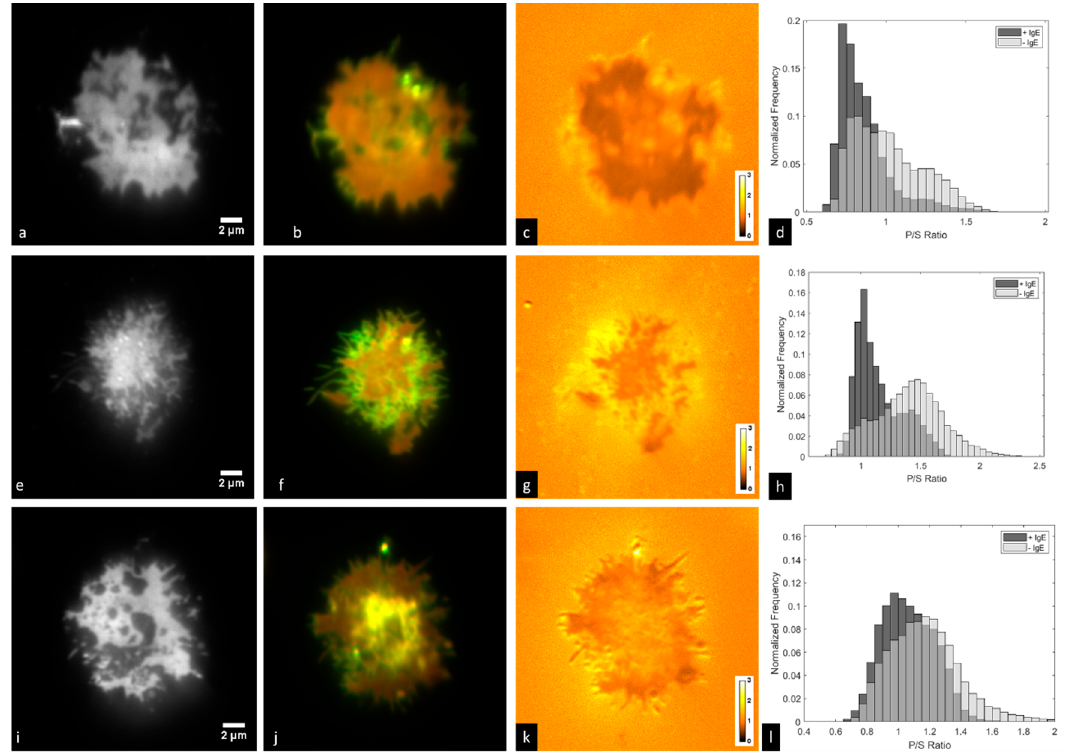
Figure 5. RBL-2H3 cells labeled with IgE-488 and DiI-C 16 in contact with a supported lipid bilayer containing 25% DNP-CAP-PE. Shown are ( a , e , i ) IgE-488; ( b , f , j ) two-color overlay of P-polarized excitation and S-polarized excitation signals from DiI-C 16 ; ( c , g , k ) P/S ratio images of DiI-C 16 signals; ( d , h , l ) histograms of membrane regions with particular P/S ratios for regions positive (+IgE) or negative ( − IgE) for IgE-bound Fc ε RI. Images were acquired with the Evolve 512 EMCCD camera and DV2 image splitter.